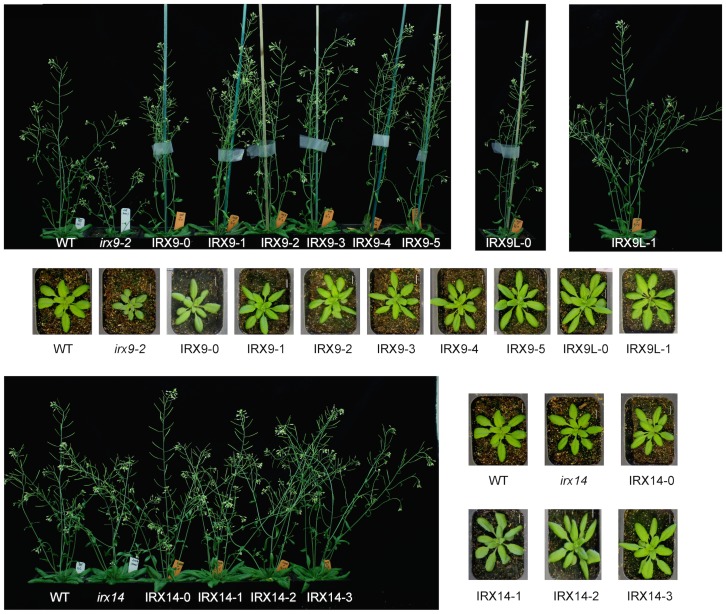
Representative photos of wild type, mutants and transformed plants.The nomenclature for the constructs used to transform the irx9 and irx14 plants is explained in Table 1. Rosettes were from 4-week-old plants and mature plants were 6-week-old.